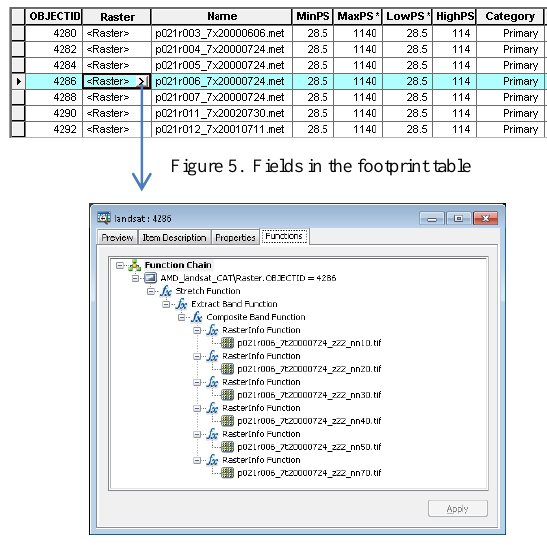
Figure 6: Raster function chain used to create the raster value in the mosaic dataset